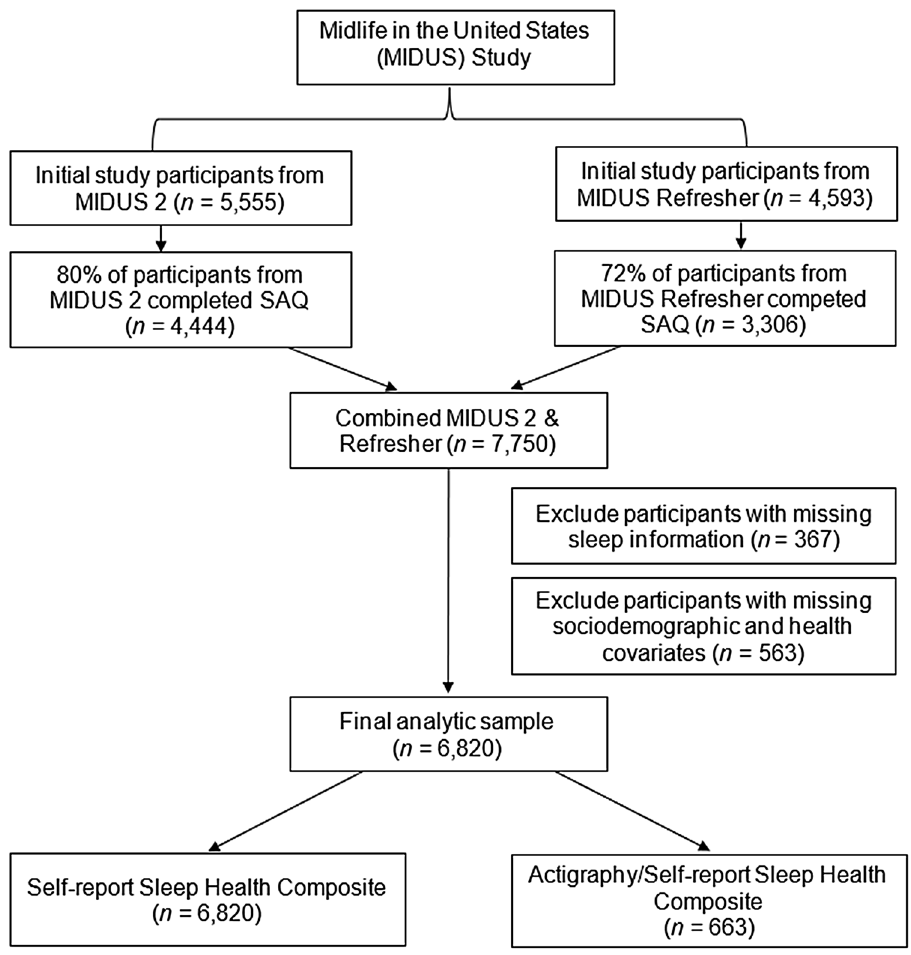
Figure 1. Flowchart of MIDUS analytic sample; SAQ = Self-Administered